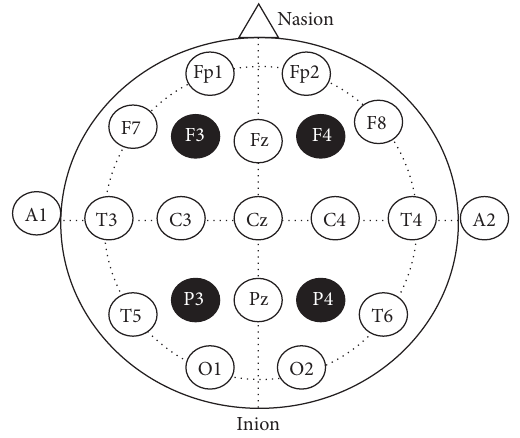
Figure 1: Depiction of the international 10–20 system; filled circles indicate the electrode positions used in this